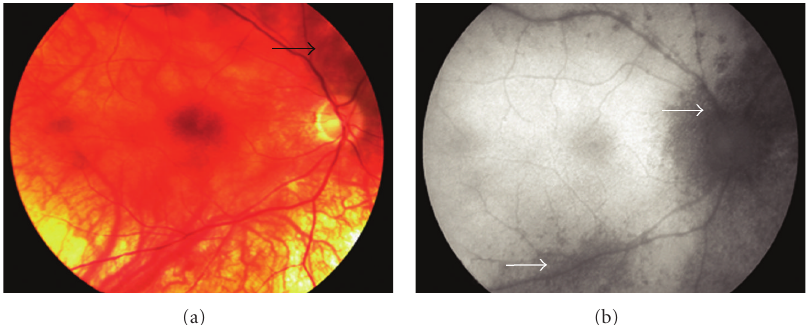
Figure 3: Images from the right eye of a 69-year-old woman with birdshot chorioretinopathy (patient 6). (a) Fundus photograph shows a poorly pigmented fundus with scattered lesions nasally and superior of the optic nerve (black arrow). (b) Autofluorescence photograph demonstrates circumferential hypoautofluorescence around the optic nerve, scattered multiple multifocal hypoautofluorescent spots, and a linear hypoautofluorescence pattern along the retinal vessels (white